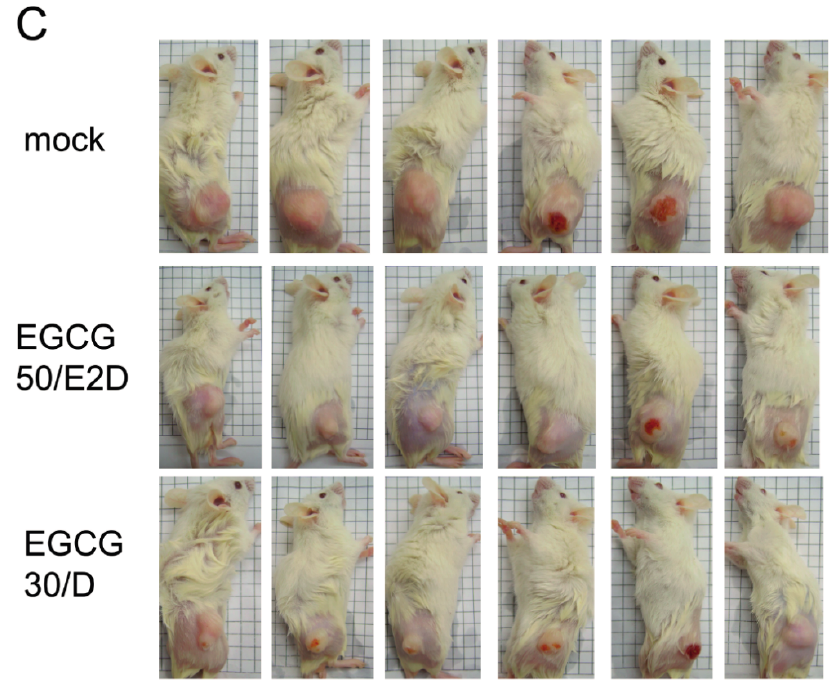
Figure 6. EGCG inhibits NPC tumor growth in vivo . NA cells were inoculated subcutaneously into SCID mice. Two groups of mice received EGCG administration: one with 50 mg/kg of EGCG every 2 days (the “50/E2D” group) and the other with 30 mg/kg of EGCG every day (the “30/D” group). The mice of the mock-treated group received only water. ( A ) The record of animal body weight during the experiment ( n = 6 mice for each group); ( B ) The tumorigenicity of NA cells was evaluated by the size of the tumors at the inoculation site using a standard procedure at 7-day intervals post-injection. Data indicate mean tumor volume ( n = 6) ± SD. **: p < 0.01, compared to the EGCG-treated groups; and ( C ) Representative photographs of tumor nodules in the mice at the 8th